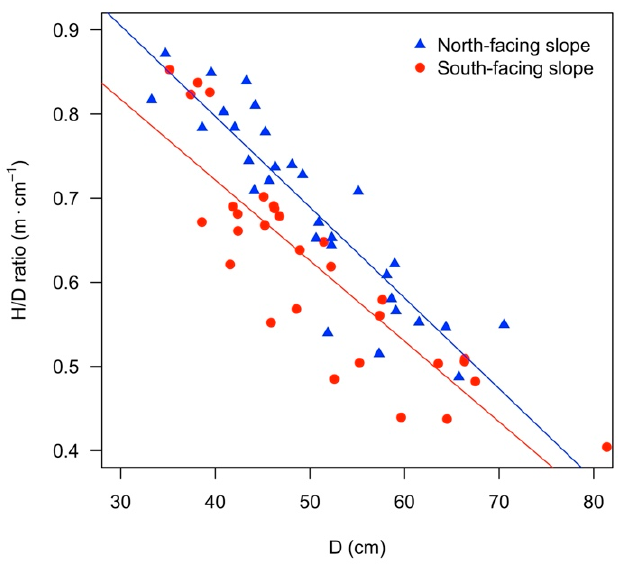
Figure 1. The relationship between H/D ratio and D for trees growing on the north-facing slope (blue triangles) and on the south-facing slope (red dots). The regression lines for the two groups follow the same color differentiation.